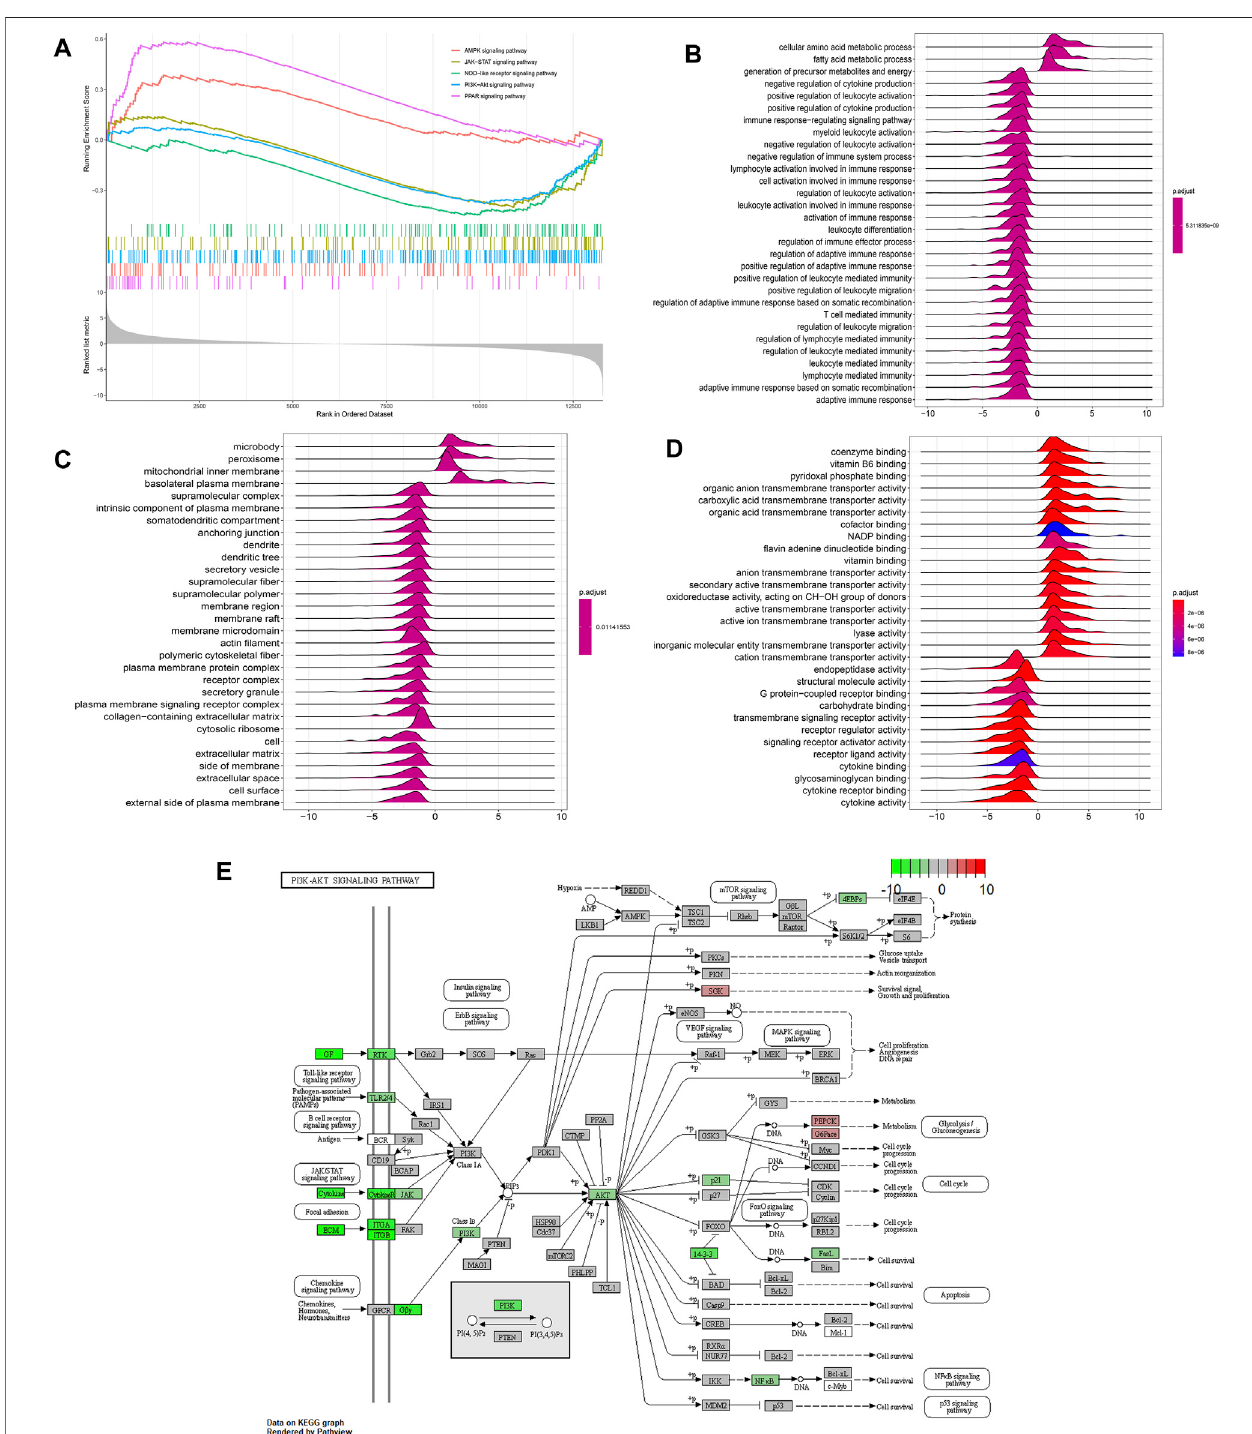
FIGURE 4 | Functional analysis of the kidney transcriptome by hirudin treatment. (A) Gene Set Enrichment Analysis (GSEA) of hirudin treatment-related key pathways. (B) biological processes (BP) of GO analysis of hirudin treatment-related functional annotations. (C) molecular function (MF) of GO analysis of hirudin treatment-related functional annotations. (D) cellular component (CC) of GO analysis of hirudin treatment-related functional annotations. (E) Schematic diagram of hirudin against RIF through PI3K/Akt pathway.